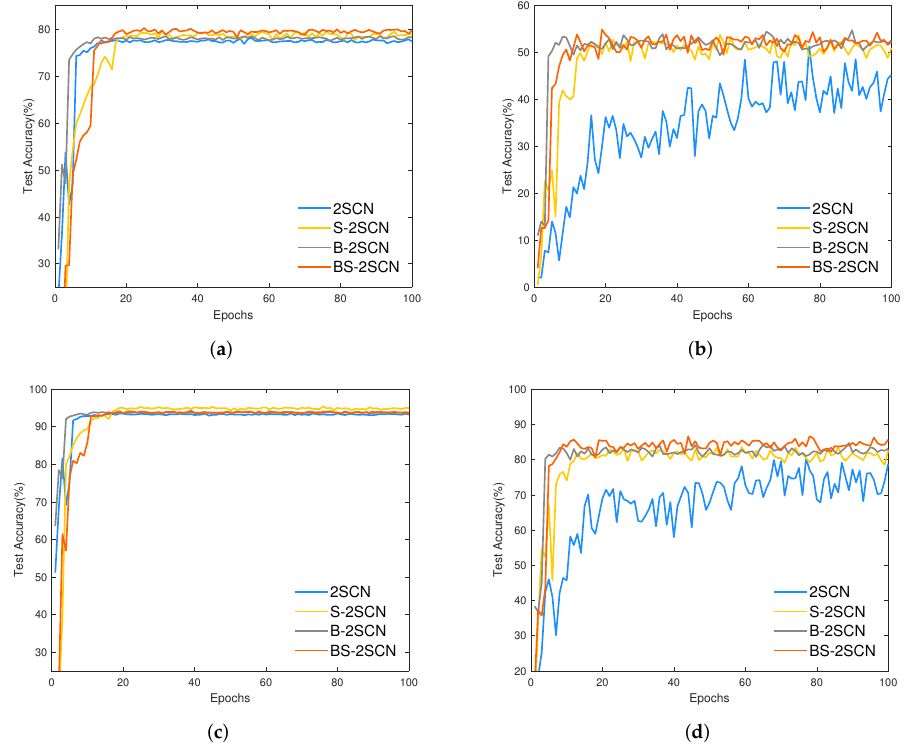
Figure 9. Accuracy of motion stream network on two data sets. ( a ) UCF101 (top1). ( b ) HMDB51 (top1). ( c ) UCF101 (top5). ( d ) HMDB51